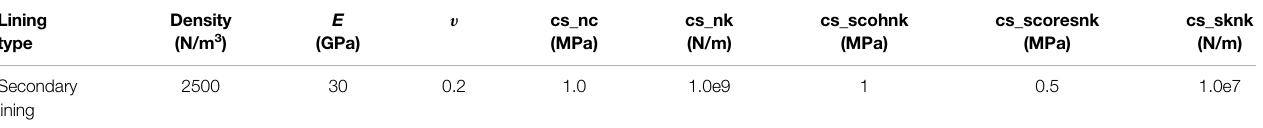
TABLE 2 | Mechanical parameters of the secondary lining (FLAC 3D 2005).